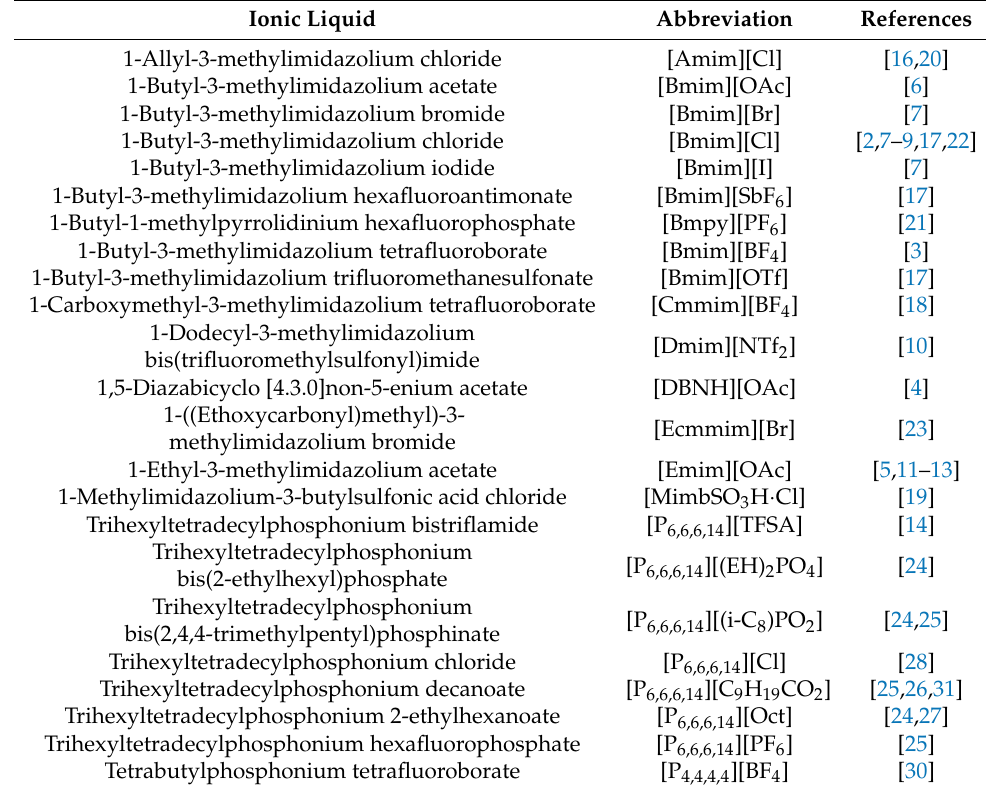
Table 2. Examples of ionic liquids employed in the fabrication of biodegradable polymer composites.